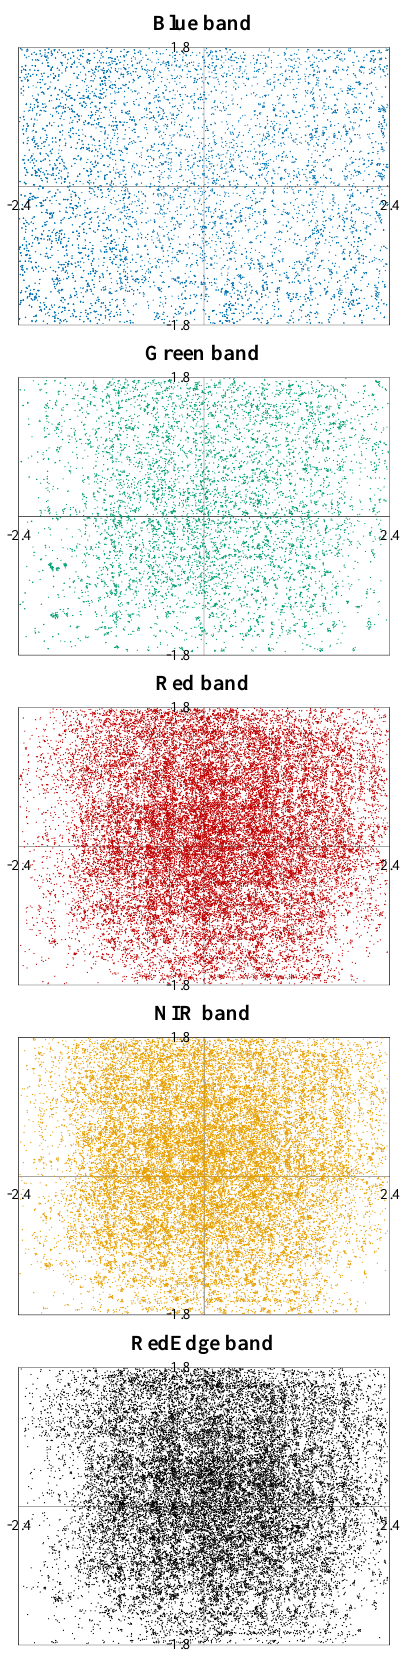
Figure 6: Distribution of image points over the format for each